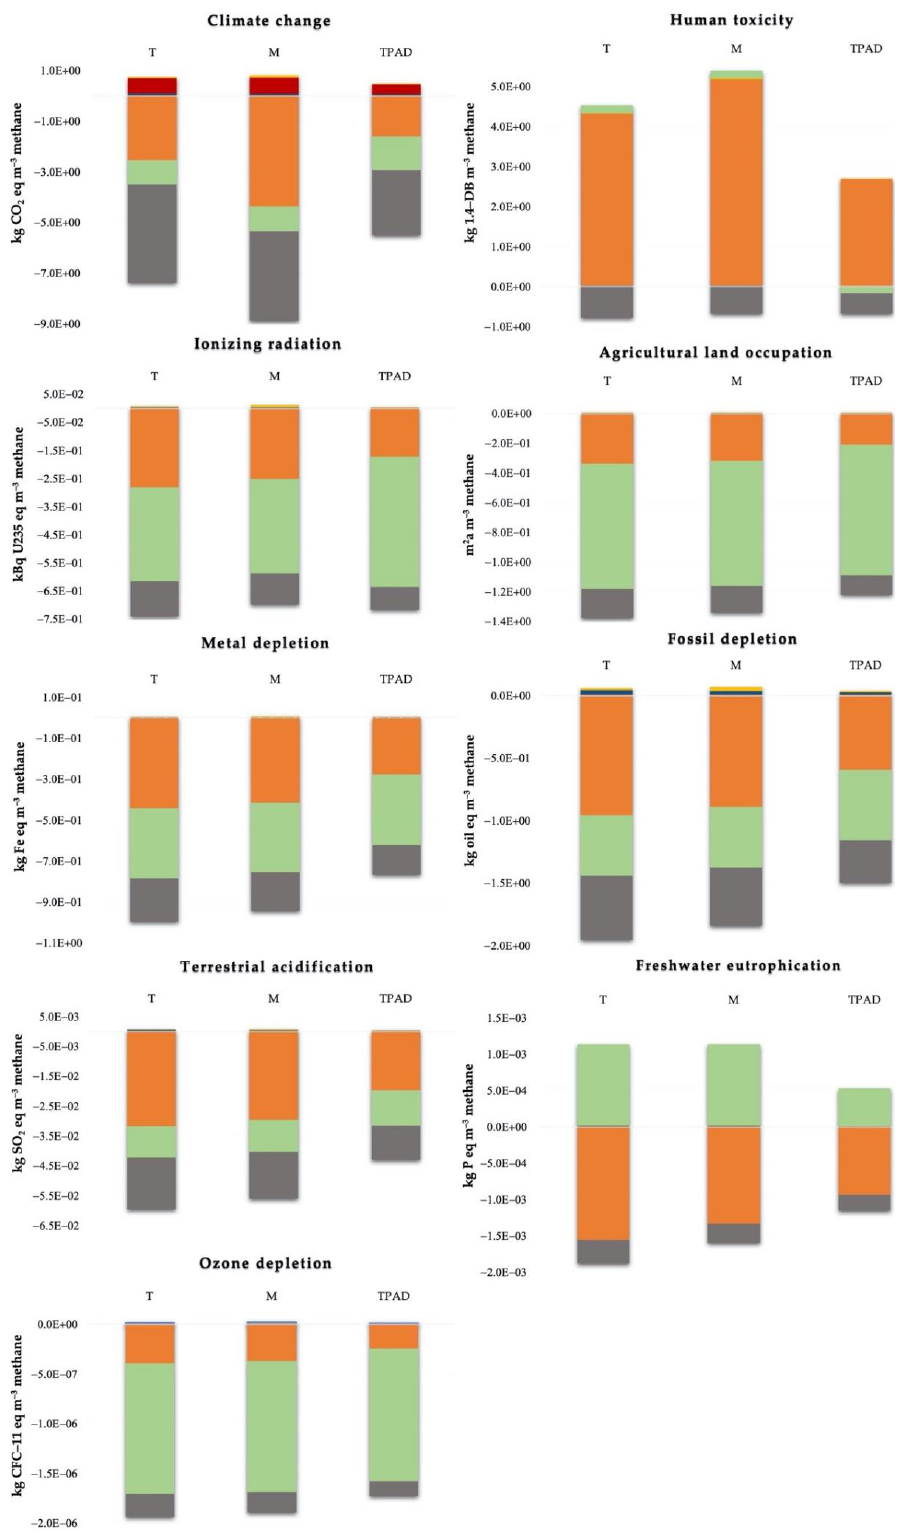
Figure 4. Contribution analysis of the potential environmental impacts for the three scenarios of the sludge line (SL-LCA): Mesophilic (M), Thermophilic (T), and Temperature-Phased Anaerobic Digestion (TPAD). Results shown for the FU: 1 m 3 of methane